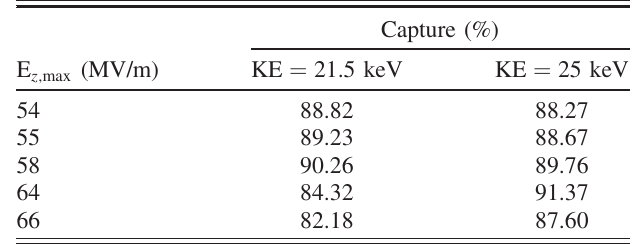
TABLE V. Capture efficiency for different E z; mized initial beam